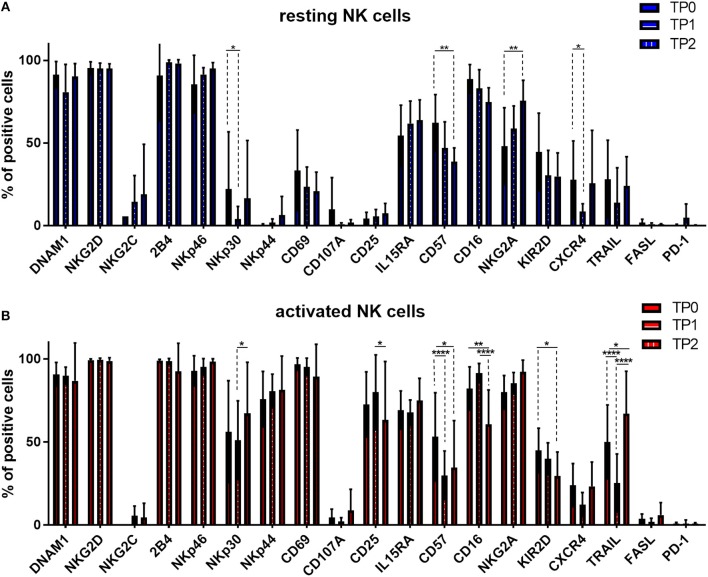
Expression of several NK cell markers significantly changed between different treatment points. NK cells from patients were isolated at different treatment points: TP0 after diagnosis, TP1 during high-dose chemotherapy and TP2 more than 21 days after stem cell transplantation. After isolation, NK cells were stained with fluorochrome-conjugated antibodies to determine surface marker expression (A) before and (B) after activation with IL-2 and Il-15. For TP0, 11 individual experiments with resting NK cells and 15 individual experiments with activated NK cells were performed (n = 11–15). For TP1, 10 individual experiments with resting NK cells and 16 individual experiments with 7 days activated NK cells were performed (n = 10–16). For TP2, 5 individual experiments with resting NK cells and 7 individual experiments with activated NK cells were performed (n = 5–7). Statistical analysis with two-way ANOVA + Sidak's multiple comparison: *p < 0.05, **p < 0.01, ***p < 0.001, ****p < 0.0001.